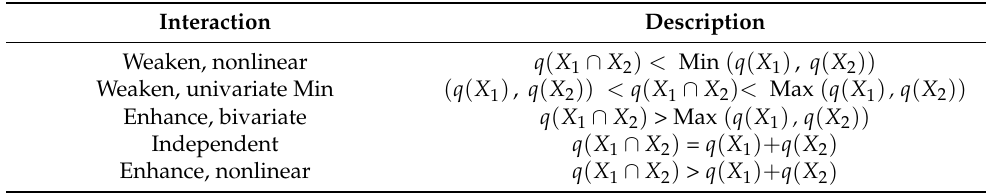
Table 1. Types of interaction between two factors [21,32,36].